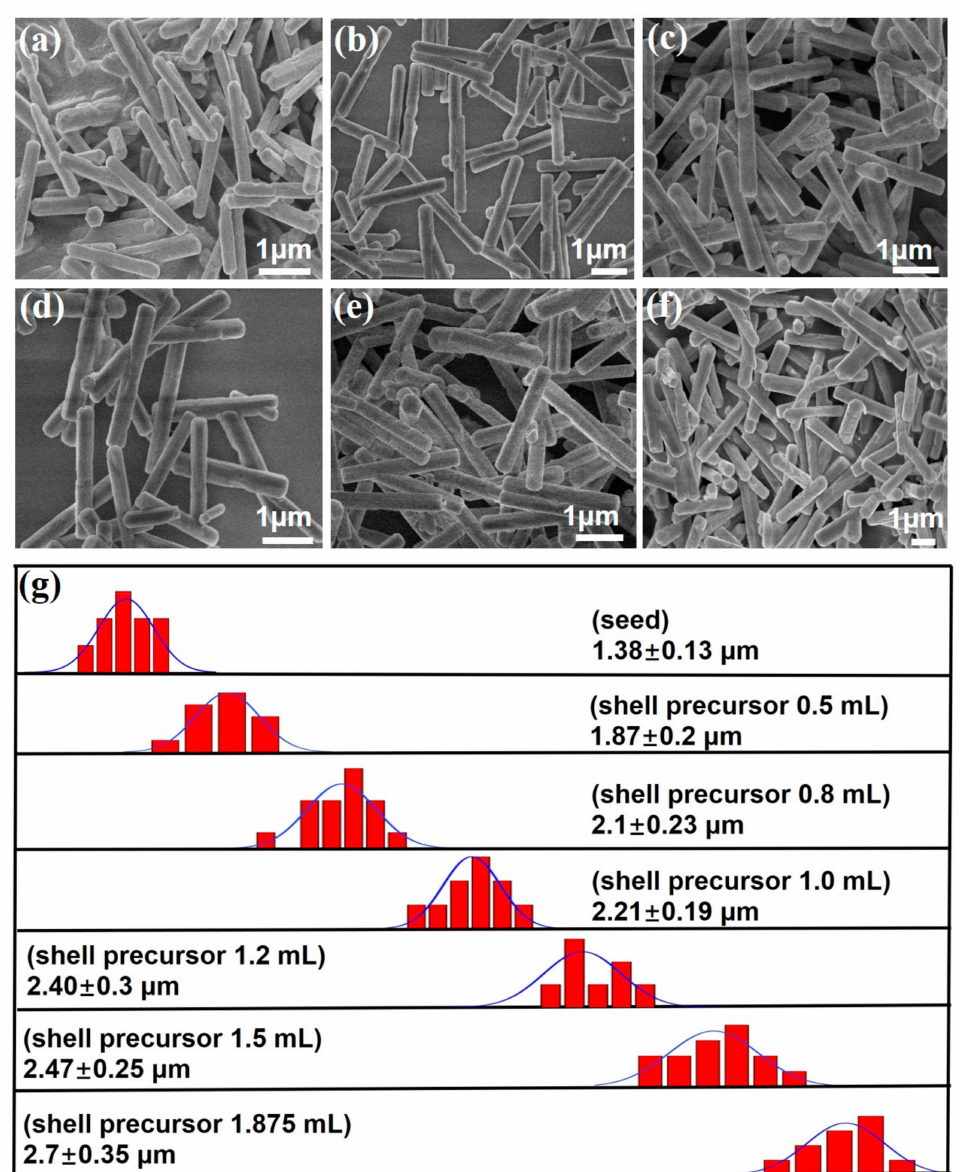
Figure 2. Investigation of NaYF 4 :Yb/Er (20/2 mol %, Y)@NaLuF 4 :Yb/Tm (20/0.2 mol %) microcrystals growth versus the amount of shell precursor. ( a – f ) are the SEM images of the core-shell microcrystals with different shell thicknesses, the volume of shell precursor: ( a ) 0.5 mL; ( b ) 0.8 mL; ( c ) 1.0 mL; ( d ) 1.2 mL; ( e ) 1.5 mL; ( f ) 1.875 mL; ( g ) Size distribution analysis of the NaYF 4 :Yb/Er (20/2 mol